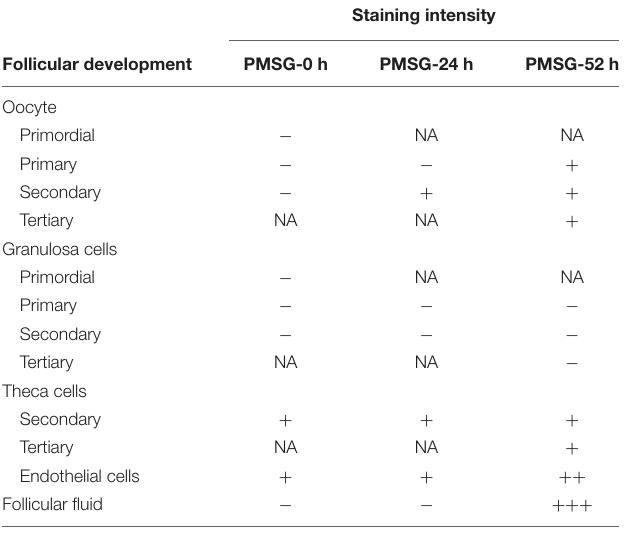
TABLE 2 | Relative abundances of ASC in the ovary during follicular development